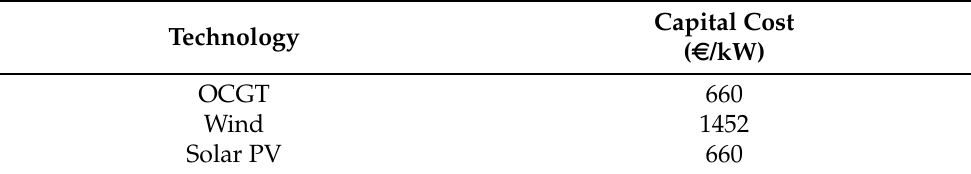
Table 1. Capital costs of generating and storage units.